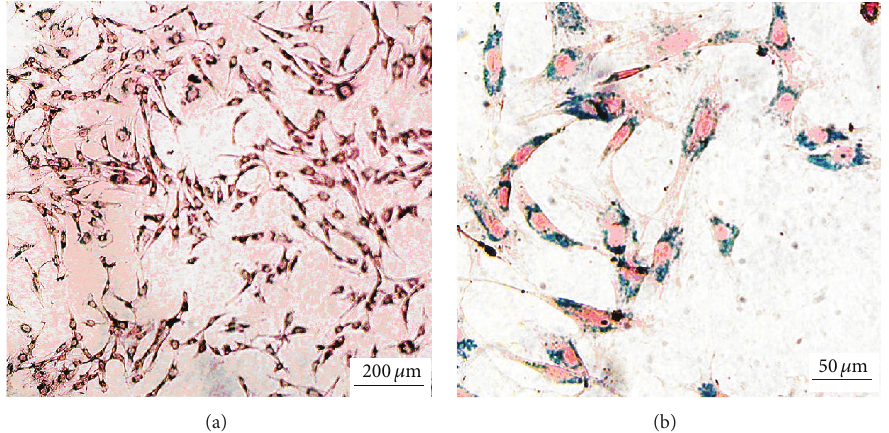
Figure 2: Prussian blue staining of the SPIO-labeled and gene-transfected BMSCs ((a), (b)). Magnification, × 100 (a), × 400 (b). Scale bar, 200 𝜇 m (a), 50 𝜇 m